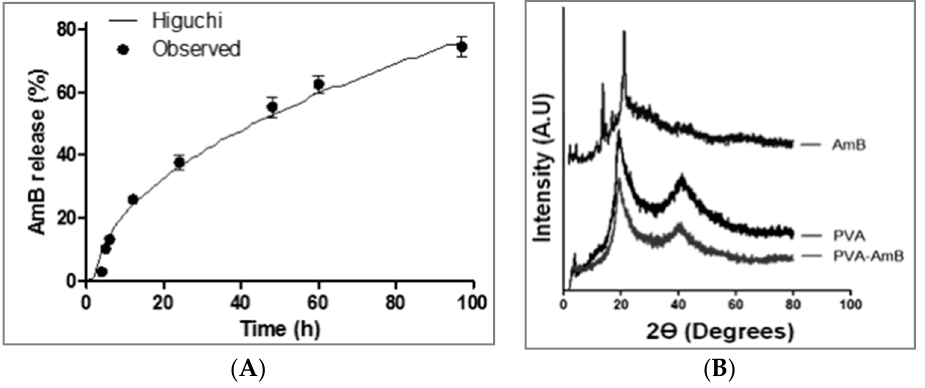
Figure 3. ( A ) Kinetic release of AmB from PVA–AmB hydrogels. Key: ( • ) experimental data (–) fitted data according to the Higuchi model. ( B ) XRD patterns of the AmB, the PVA–H, and the PVA–AmB hydrogels.